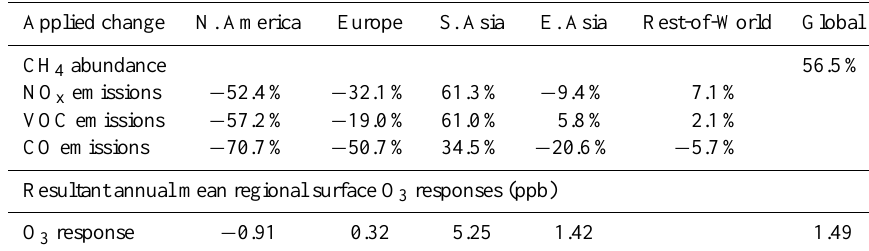
Table A2. Regional emission changes and estimated O 3 responses for 2050 from the RCP 8.5 scenario. Applied